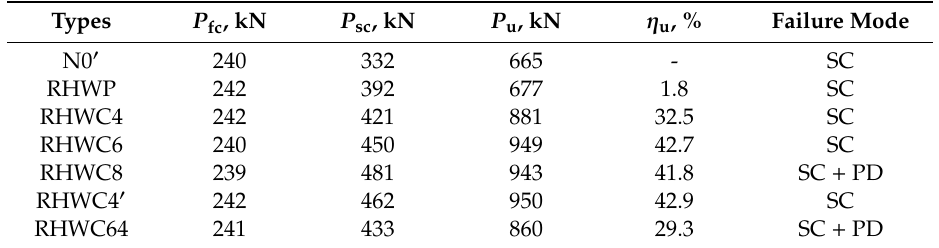
Table 8. Summary of experimental